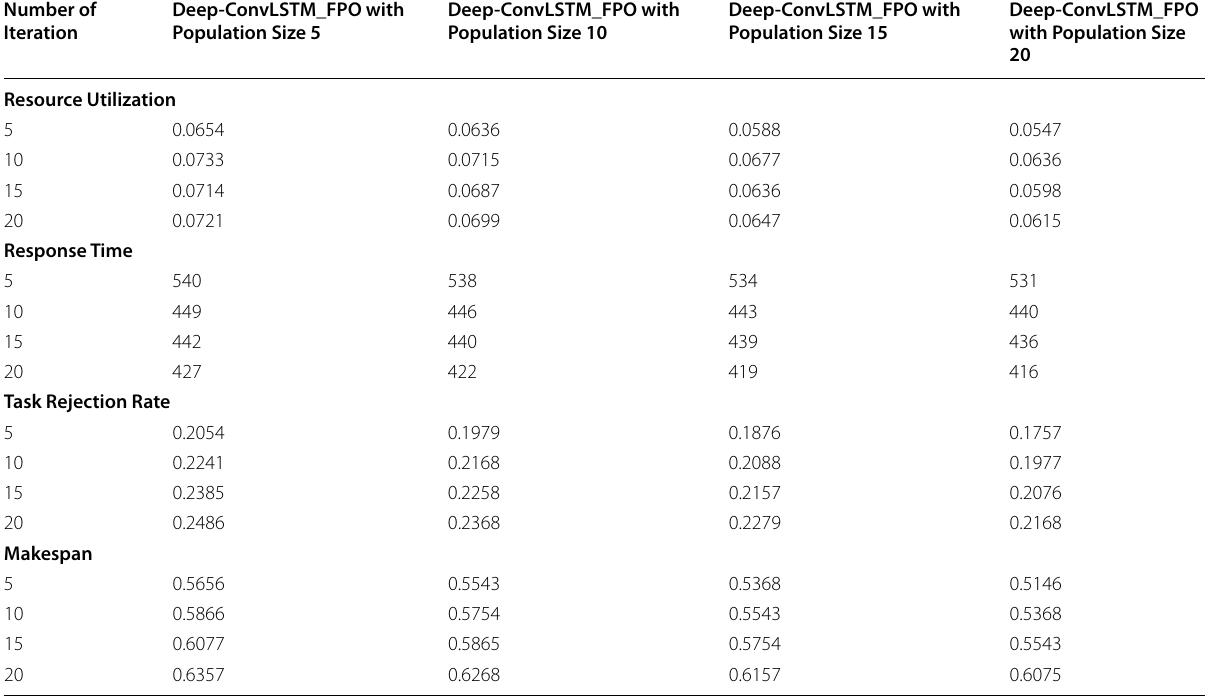
Table 3 Performance Assessment of Deep-ConvLSTM_FPO with Task Size 200